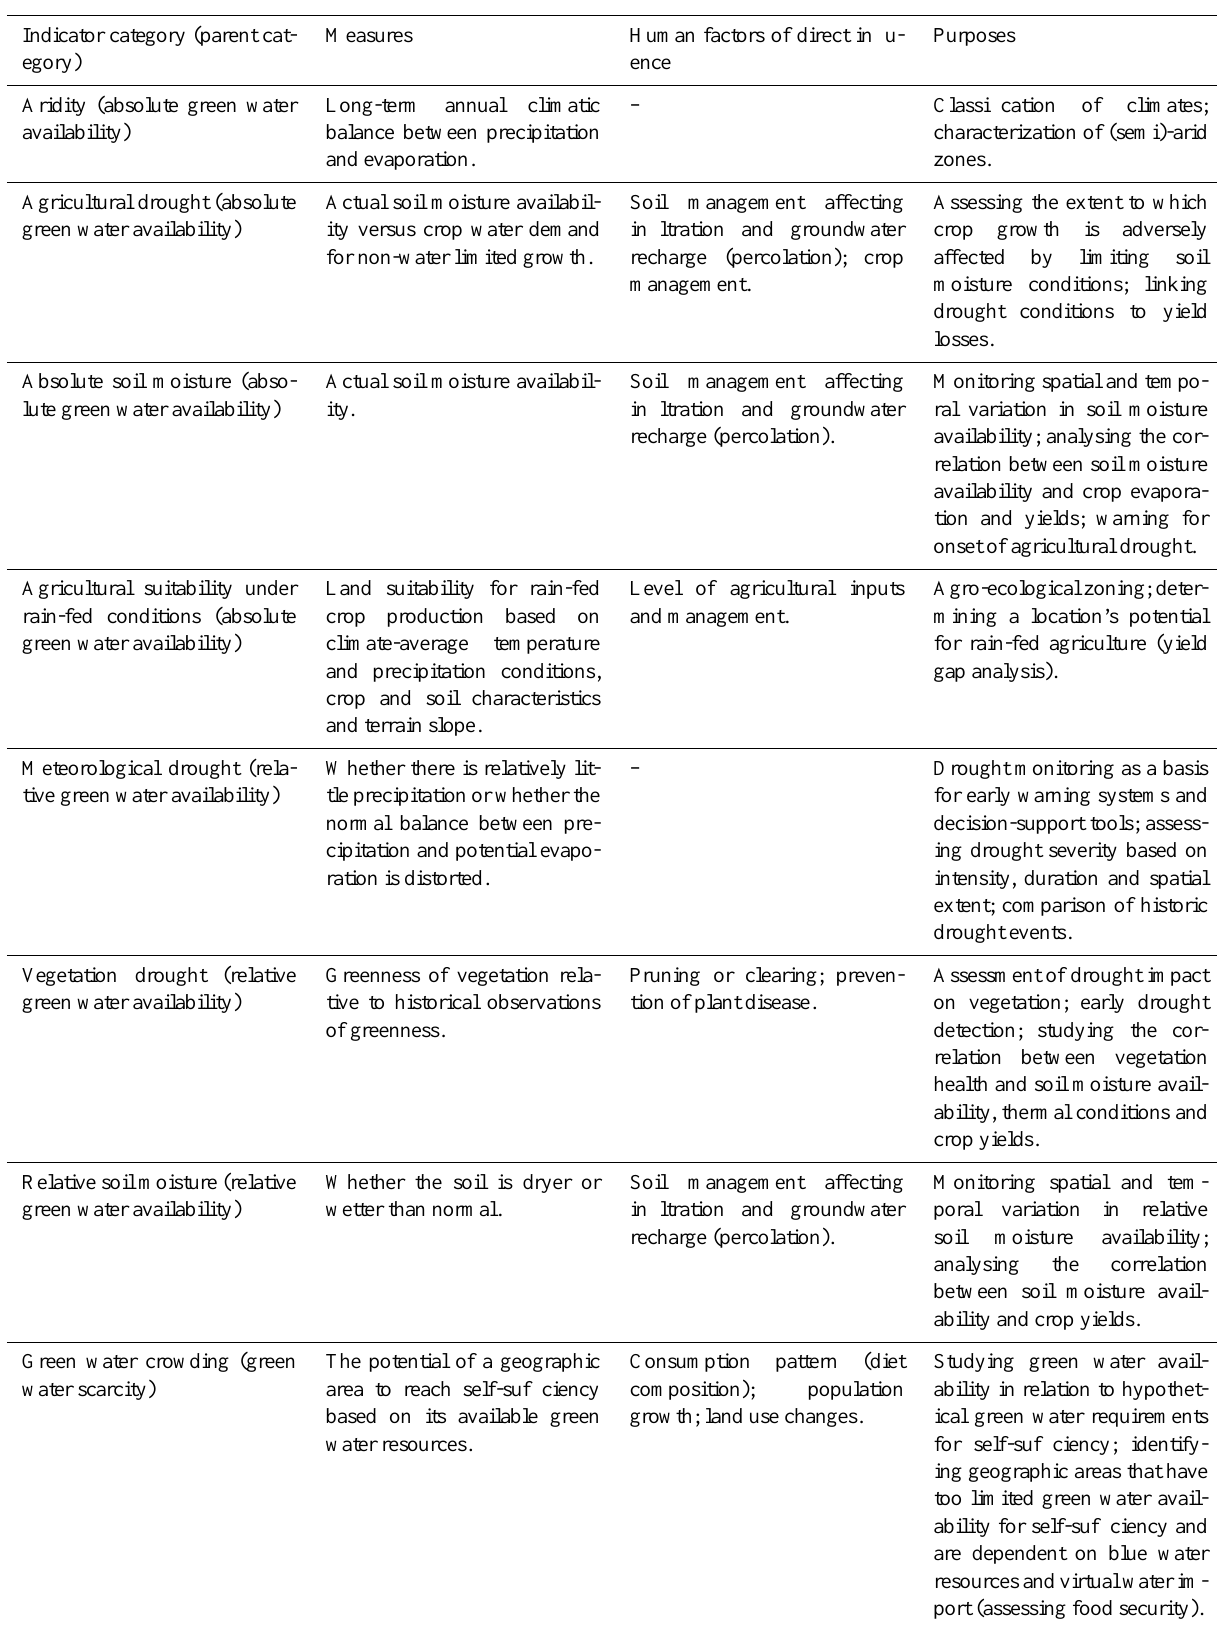
Table 1. Overview of indicator categories. Indicator category (parent